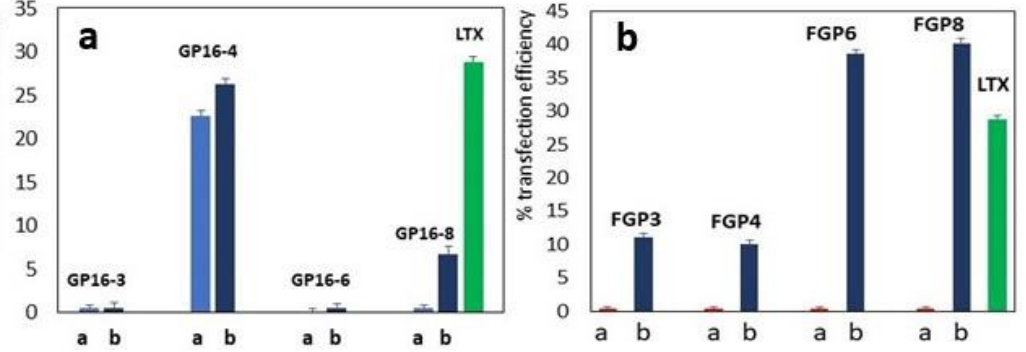
Figure 7. Gene delivery ability on RD4 cells of GP16_ n hydrogenated gemini surfactants (left) and partially fluorinated gemini surfactants FGPn as a function of the spacer length, n : ( a ) experiments done only with the surfactants and ( b ) with surfactant:DOPE ratio = 1:2. Positive control by a commercial reagent is in green. Spacer 12 (not shown) is unable to deliver DNA. See [18,21].